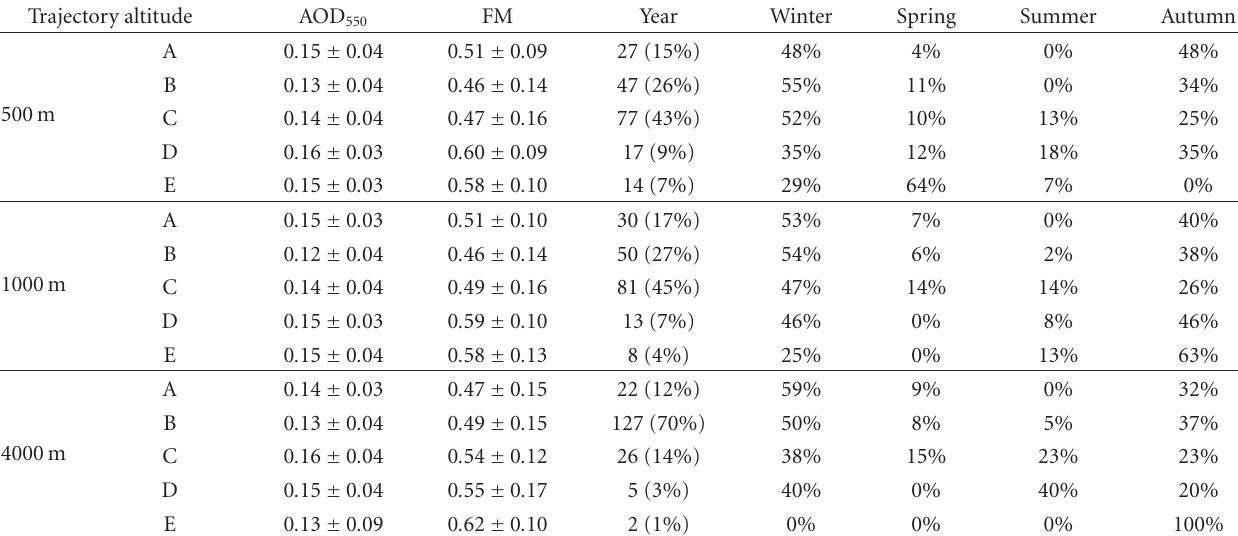
Table 3: As in Table 1, but for the CM aerosols.